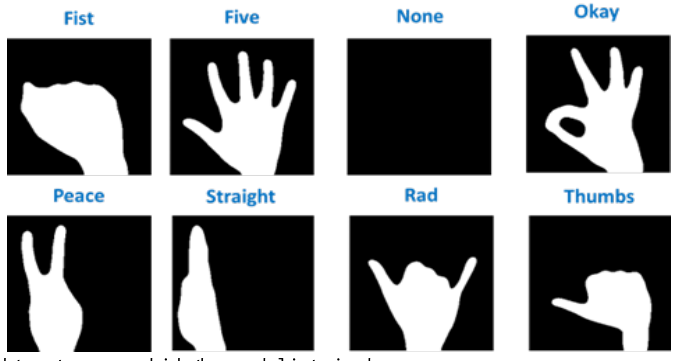
Figure 1. Eight gestures on which the model is trained. The CNN model has 99.55% training accuracy and 98.73% validation accuracy. In order to get these results, we have built our model using the proper number of convolutions, max pooling, dense, dropout, and flattened layers.